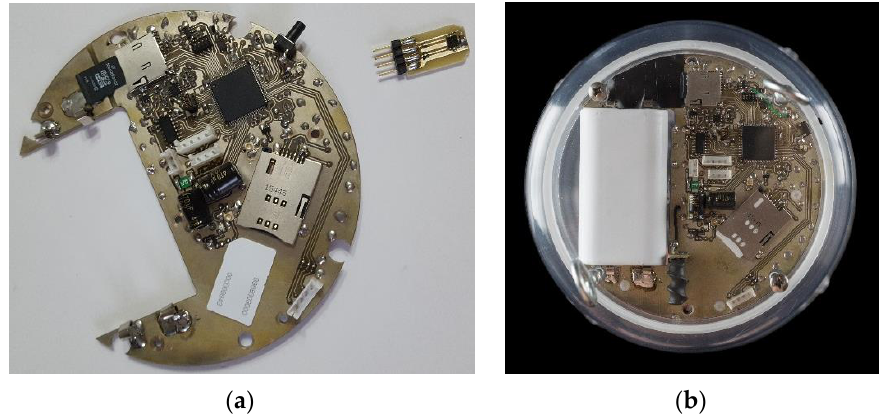
Figure 4. The electronic board of the automated fruit fly trap ( a ) and final placement of the board in the trap ( b ).